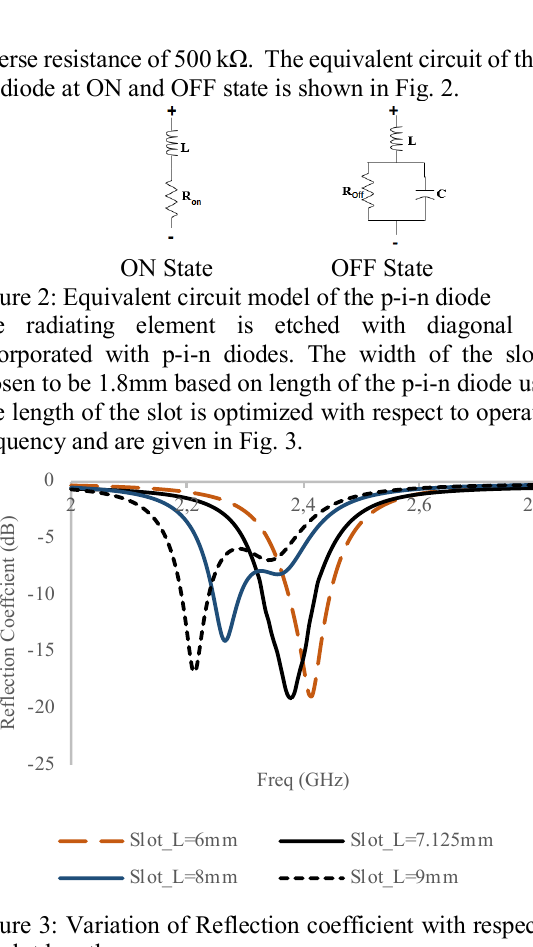
Figure 3: Variation of Reflection coefficient with respect to the slot length